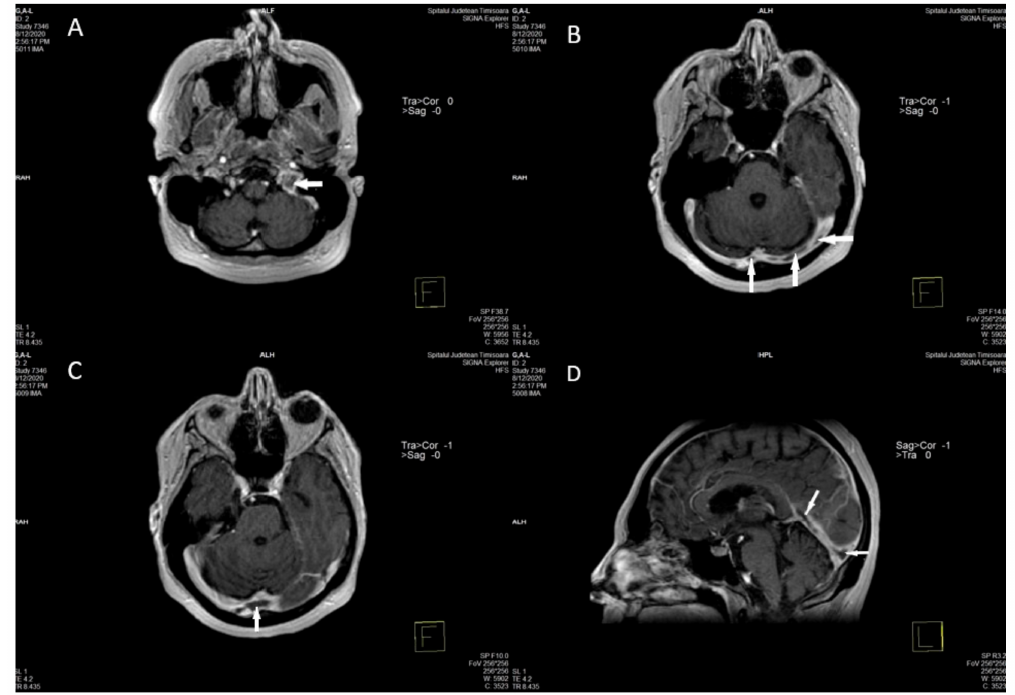
Figure 4. Axial and sagittal T1 postcontrast magnetic resonance images demonstrate extensive filling defects throughout the dural sinuses (arrows—left sigmoid and jugular bulb) ( A ), left and right transvers sinuses ( B ), sinus confluence ( C ), and straight sinus ( D